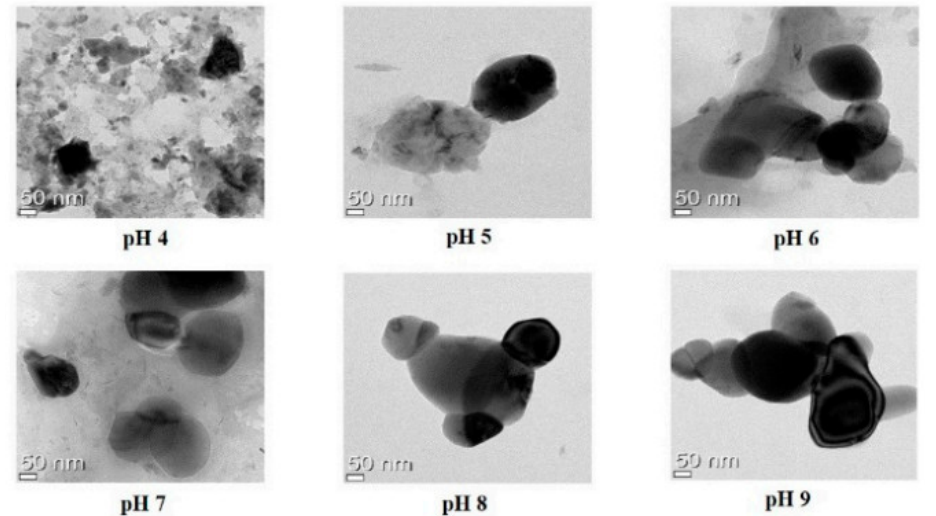
Figure 4. TEM images of quercetin-loaded with different pH levels [29]. “Reproduced with permission from reference”. sion from